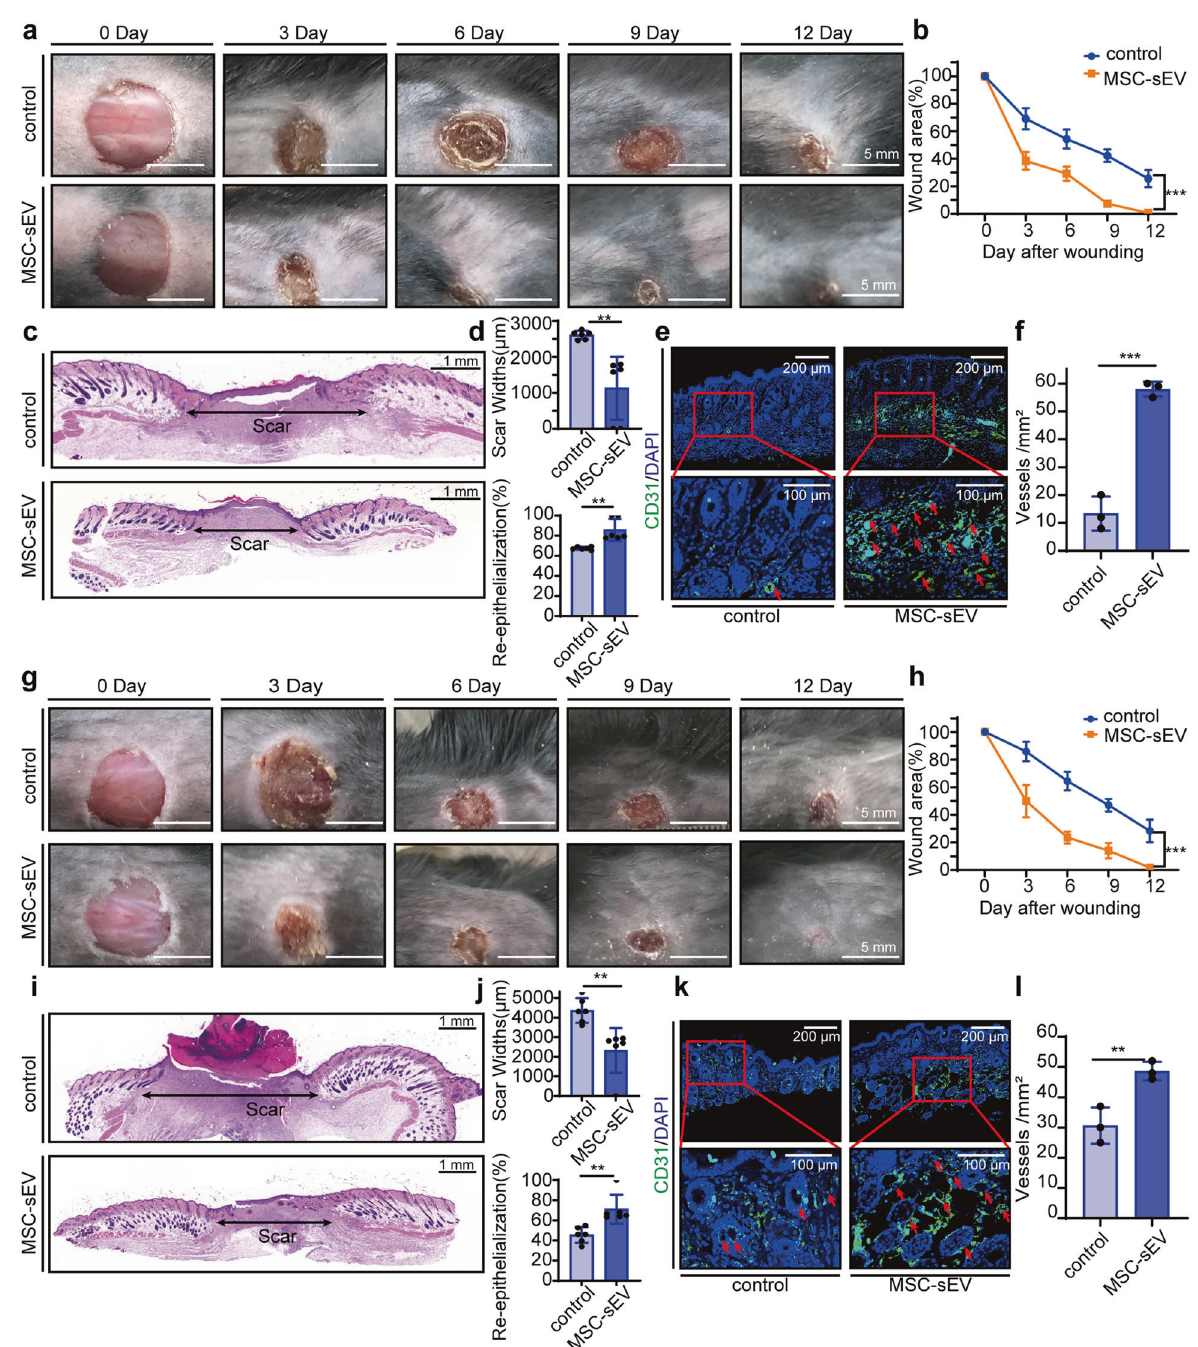
Fig. 4 MSC-sEV promoted wound closure and blood vessel formation in natural aging and type-2 diabetes mice models. a Representative cutaneous wound photographs in senescent C57BL/6mice model at days 0, 3, 6, 9, and 12 after the operation treated with PBS (control), MSC- sEV 200 μ g around wounds (scale bar, 5 mm). b Quanti fi cation of the wound areas during the wound-healing process. n = 6, *** p < 0.001 at Day 12. c H&E staining of the skin tissue around the wound at day 12 after the operation (horizontal arrows indicated the scar width; scale bar, 1 mm). d Quanti fi cation of the scar width and percentage of re-epithelialization around the wound. n = 6, ** p < 0.01. e Representative immuno fl uorescence staining images positive cells of CD31 (green staining) and DAPI in paraf fi n-embedded sections of senescent C57BL/ 6mice dorsal skin injected PBS (control) or MSC-sEV. Red arrows indicate tubes formed around the wound (scale bar, 200 μ m). f Quanti fi cation of vessels formed around the scar. n = 3, *** p < 0.001. g Representative dorsal wound photographs in type-2 diabetes C57BL/6mice model at day 0, 3, 6, 9, and 12 after the operation treated with PBS (control), MSC-sEV 200 μ g around wounds (scale bar, 5 mm). h Quanti fi cation of the wound areas during the wound-healing process. n = 6, *** p < 0.001 at Day 12. i H&E staining of the skin tissue around the wound at day 12 after the operation (horizontal arrows indicated the scar width; scale bar, 1 mm). j Quanti fi cation of the scar width and percentage of re- epithelialization around the wound. n = 6, ** p < 0.01 . k Representative immuno fl uorescence staining images positive cells of CD31 (green staining) and DAPI in paraf fi n-embedded sections of diabetic C57BL/6mice dorsal skin injected PBS (control) or MSC-sEV. Red arrows indicate tubes formed around the wound (scale bar, 200 μ m). l Quanti fi cation of vessels formed around the scar. n = 3, ** p < 0.01